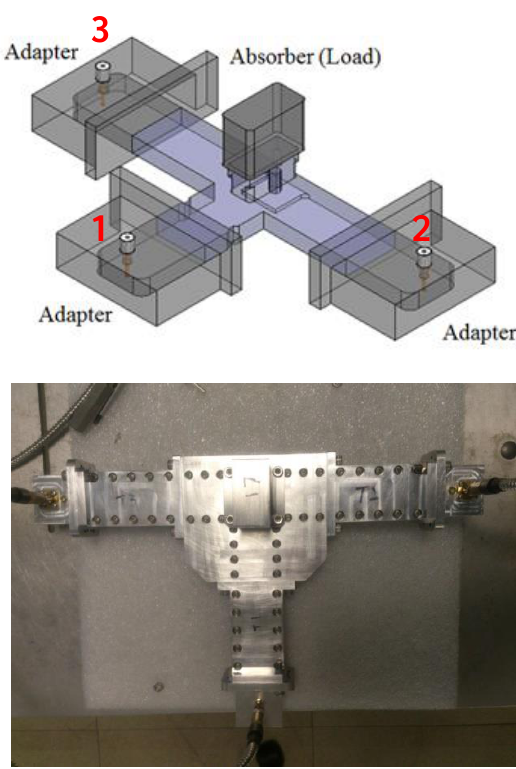
Figure 7: Geometry of the 2-to-1 power combiner.